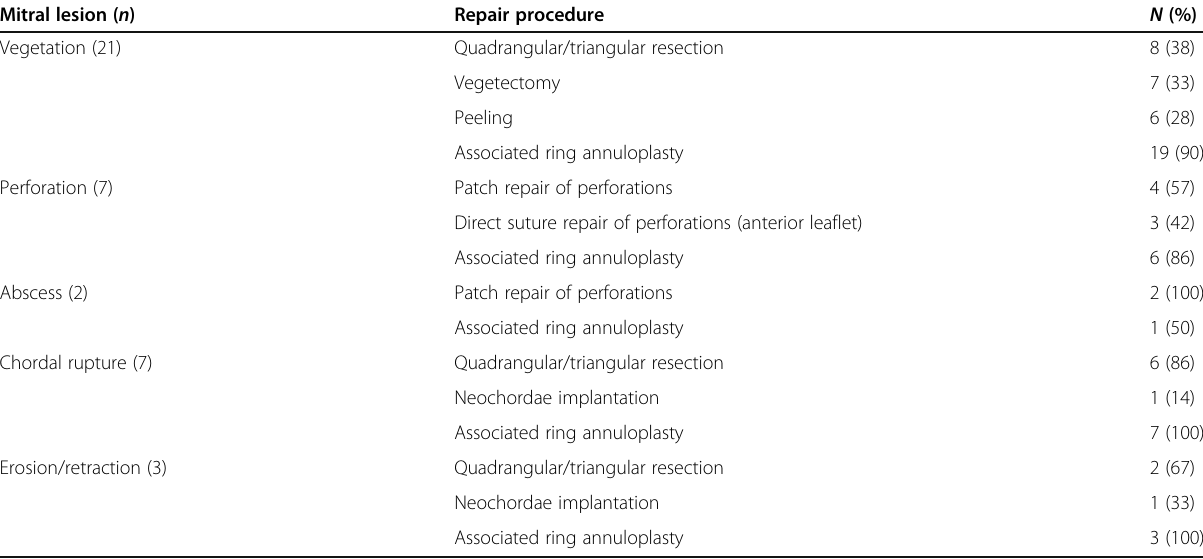
Table 2 Surgical procedures for valve repair